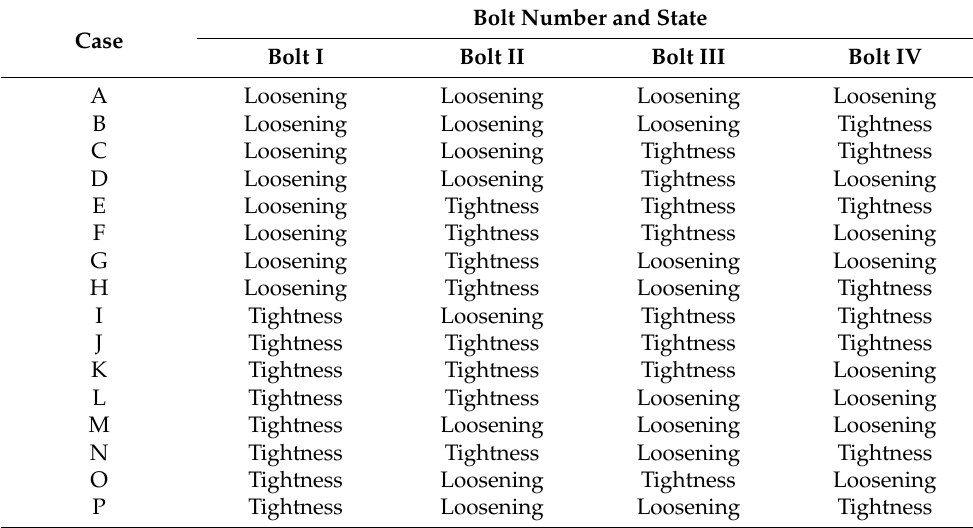
Table 1. Bolt-loosening cases.